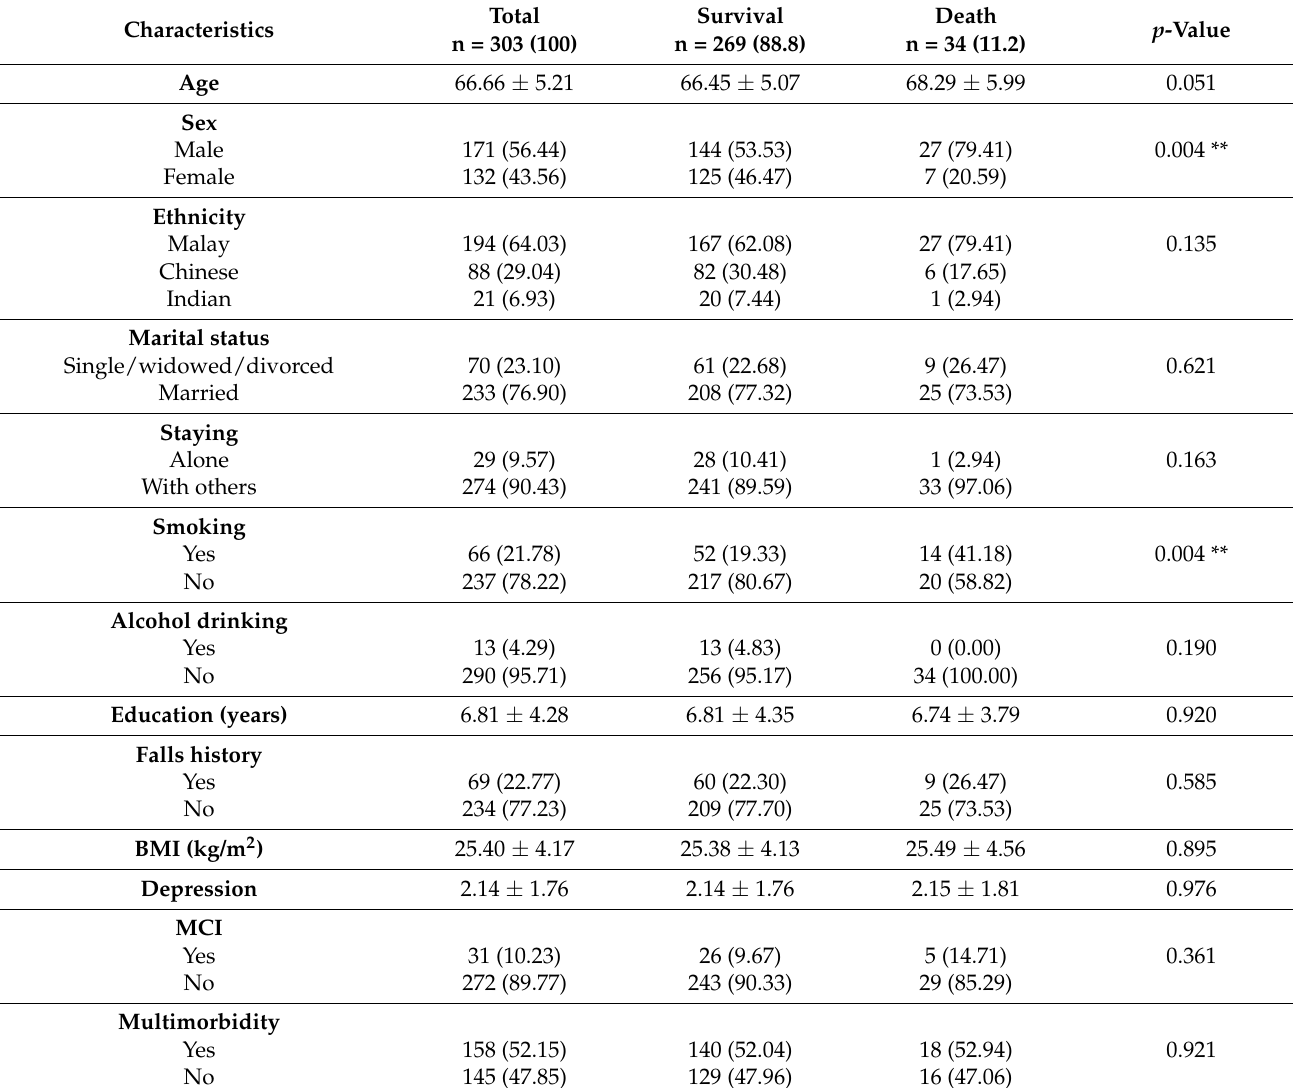
Table 1. The baseline attributes of participants, total and by mortality status at 5-year